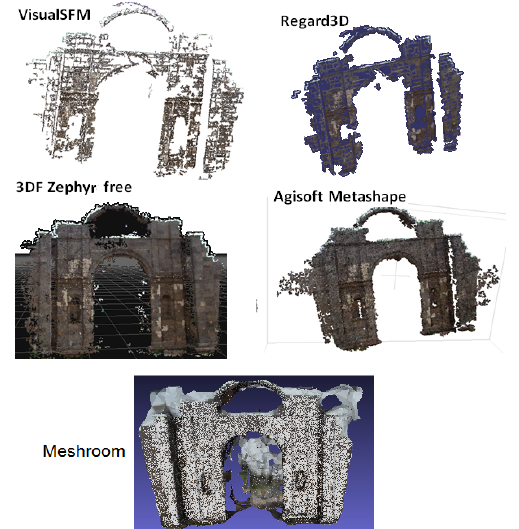
Figure 11. Dense Point clouds processed from 5 images of the Western